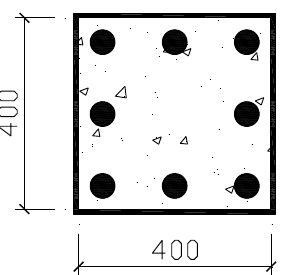
Figure 10. An eight-steel rebar-reinforced concrete element wrapped with CFRP plate as an anode.